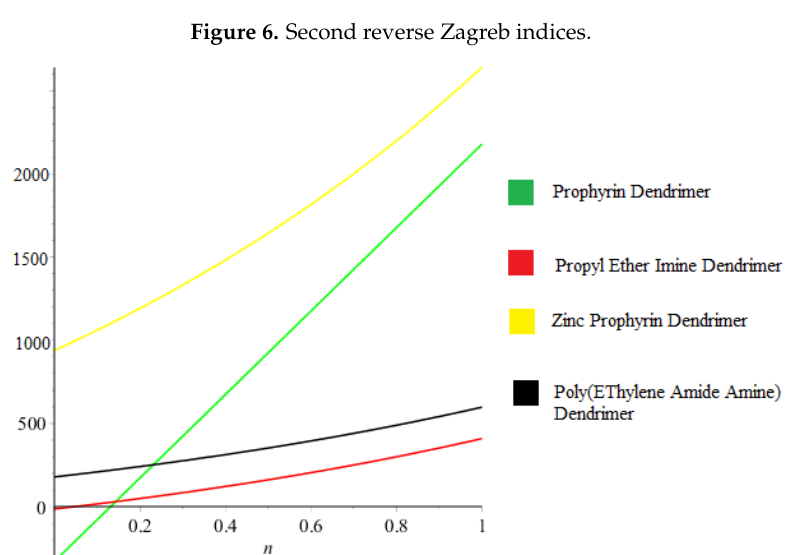
Figure 6. Second reverse Zagreb indices.